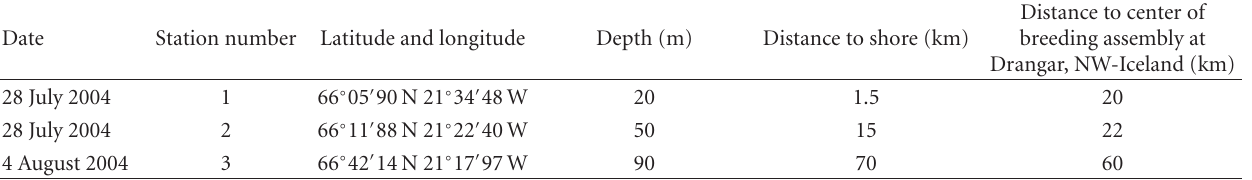
Table 1: Dates of sampling of cod, locations of sampling sites (see Figure 1), and distances to nearest coastline and to the center of the breeding assemblies of grey seals ( Halichoerus grypus ), at Drangar o ff the coast of NW-Iceland.